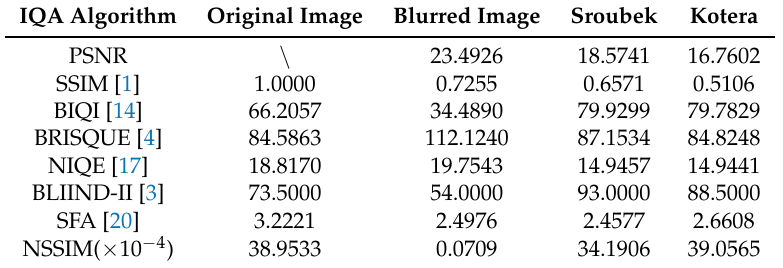
Table 11. IQA algorithms performance on Group 1 restorations. Original image is the reference (sharp) image given by LIVE II [26] dataset. NSSIM represents the quality score given by the proposed metric.